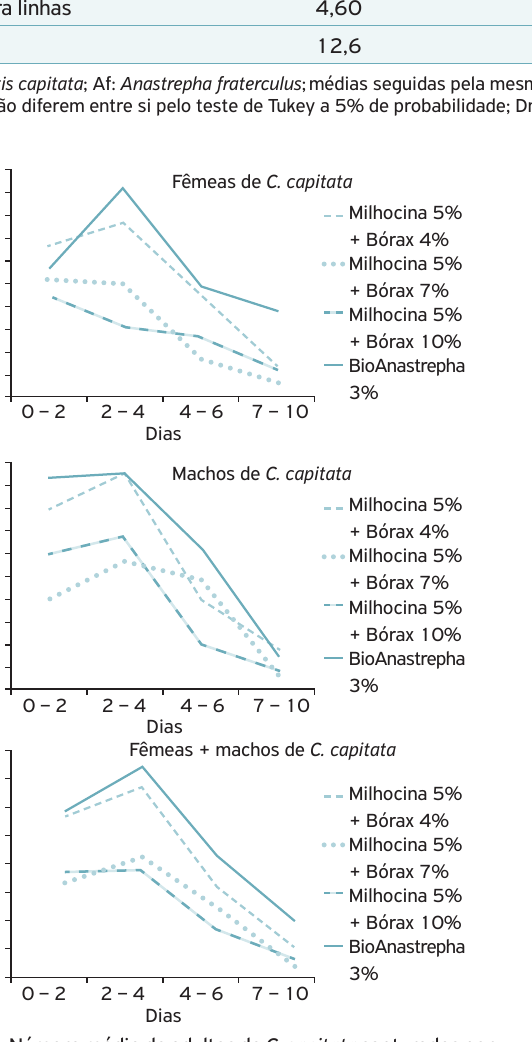
Figura 3. Número médio de adultos de A. fraterculus capturados por armadilhas McPhail, contendo diferentes atraentes alimentares